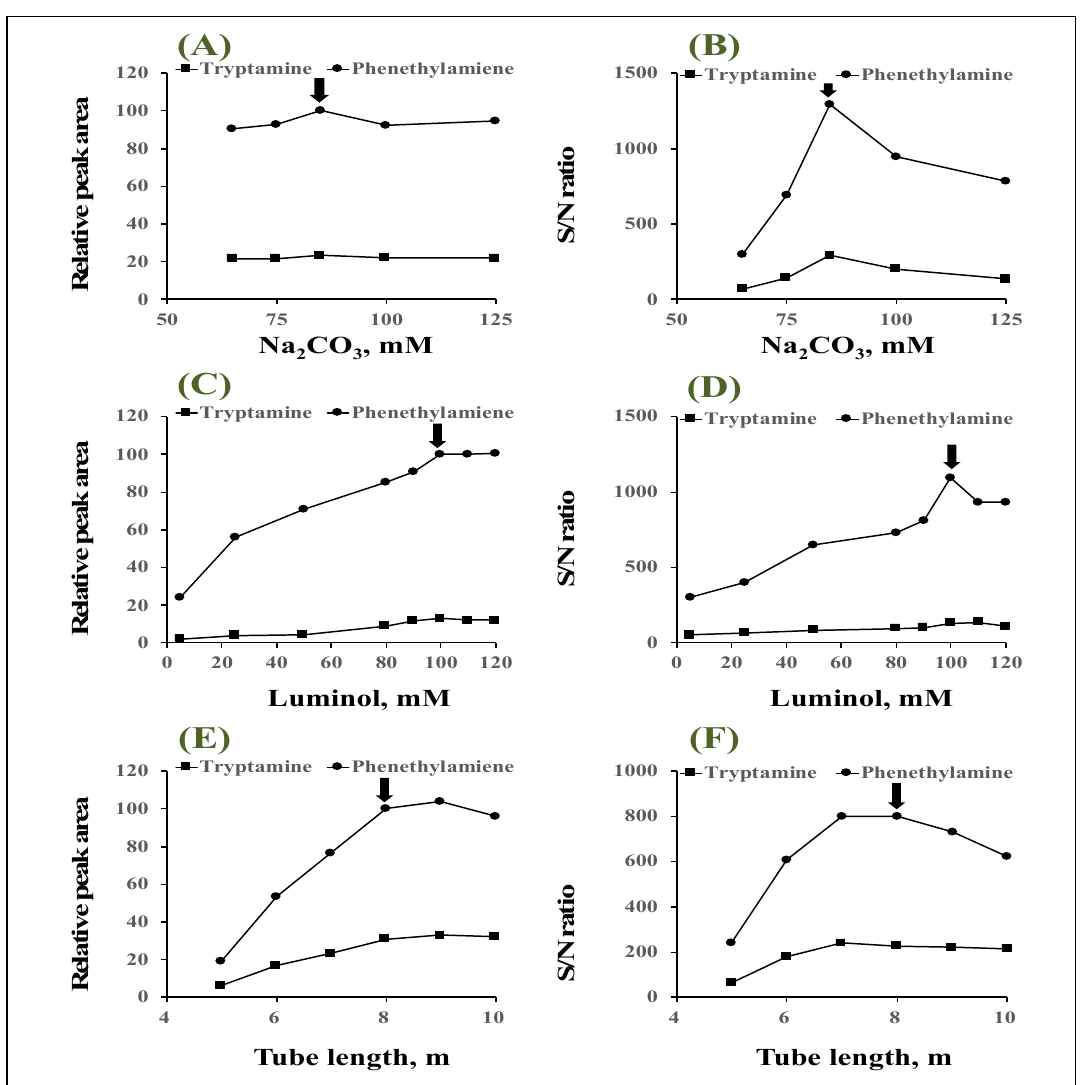
Figure 5. Effects of sodium carbonate concentration on ( A ) relative peak area and ( B ) S/N ratio. Effects of luminol concentration on ( C ) relative peak area and ( D ) S/N ratio. Effects of tube length of photoreactor on ( E ) relative peak area and ( F ) S/N ratio.